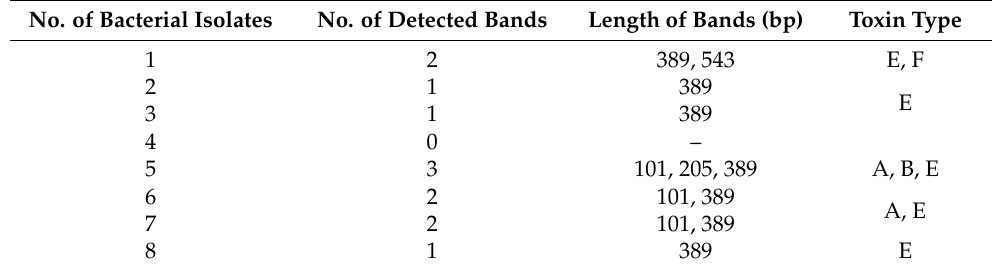
Table 5. The banding pattern for the eight studied bacterial isolates (isolated from Beheira gover- norate) using multiplex PCR.